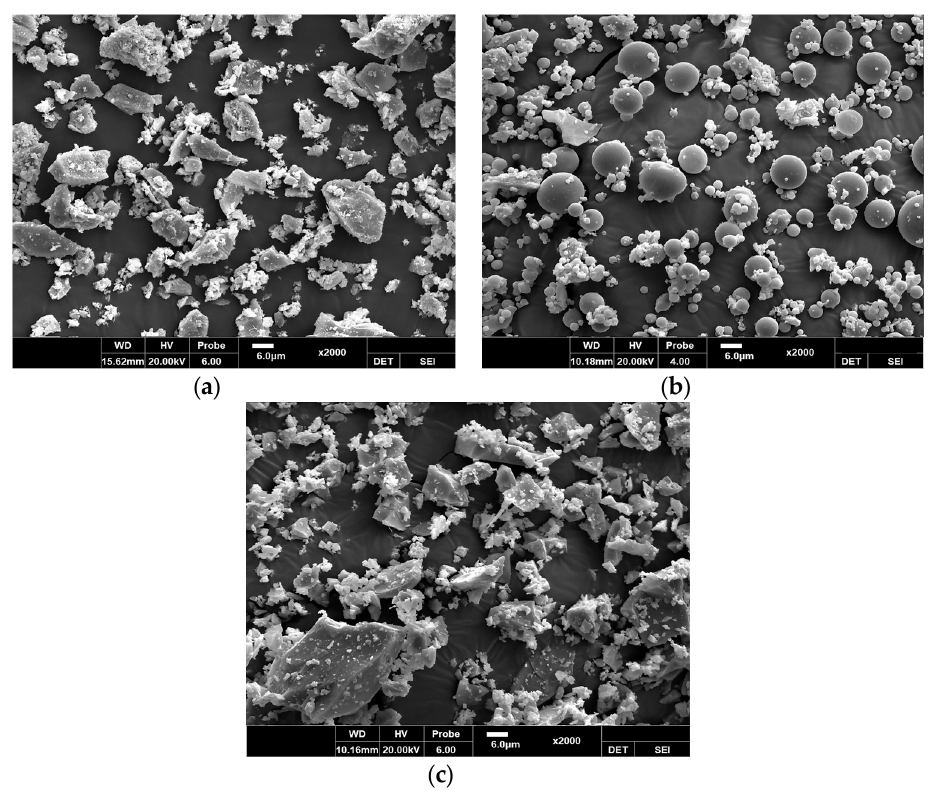
Figure 2. Scanning electron microscope images of the binder types: ( a ) OPC and ( b ) FA, compared with ( c ) GGBFS by Lee, adapted from [26].